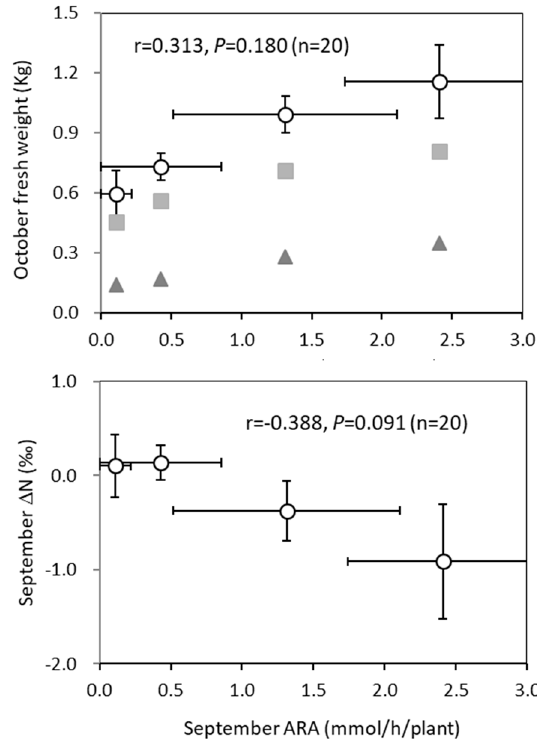
Figure 7. Relationship of ARA in September with fresh weight in October and ∆ 15 N content in September in sweet potato tubers (Beniharuka) with different origins during the course of cultivation in an experimental field. Closed squares and triangles represent the fresh weights of the aboveground and underground parts of the sweet potatoes, respectively. The error bars indicate standard errors ( n = 5), and Pearson correlation coefficient was examined ( n = 20).